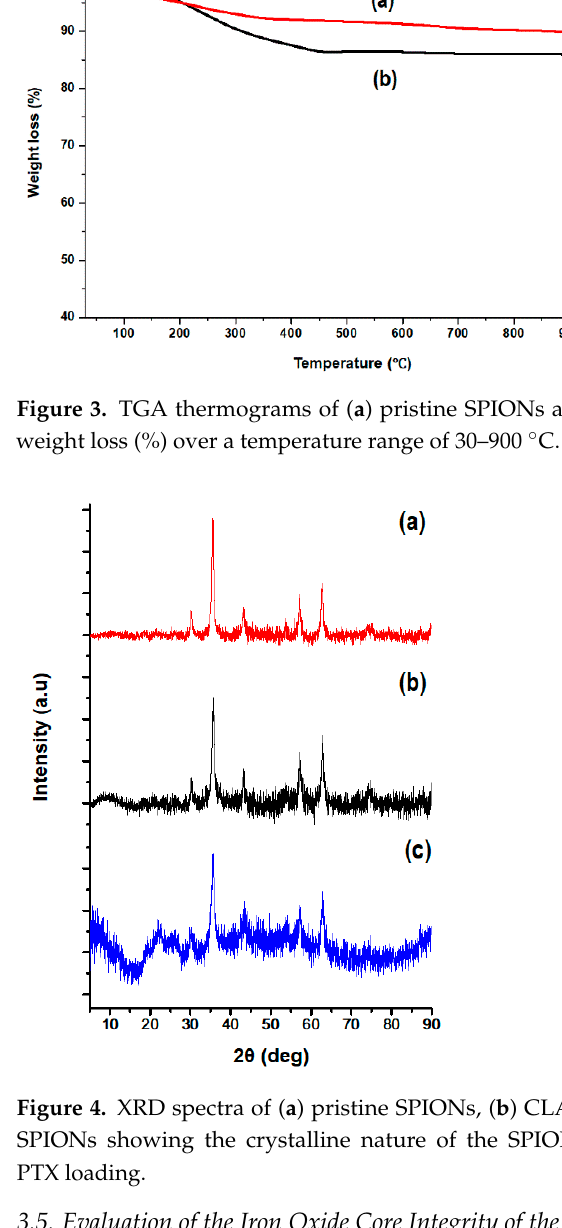
Figure 4. XRD spectra of ( a ) pristine SPIONs, ( b ) CLA-coated SPIONs, and ( c ) CLA-coated PTX- SPIONs showing the crystalline nature of the SPIONs before and after the CLA coating and PTX loading.